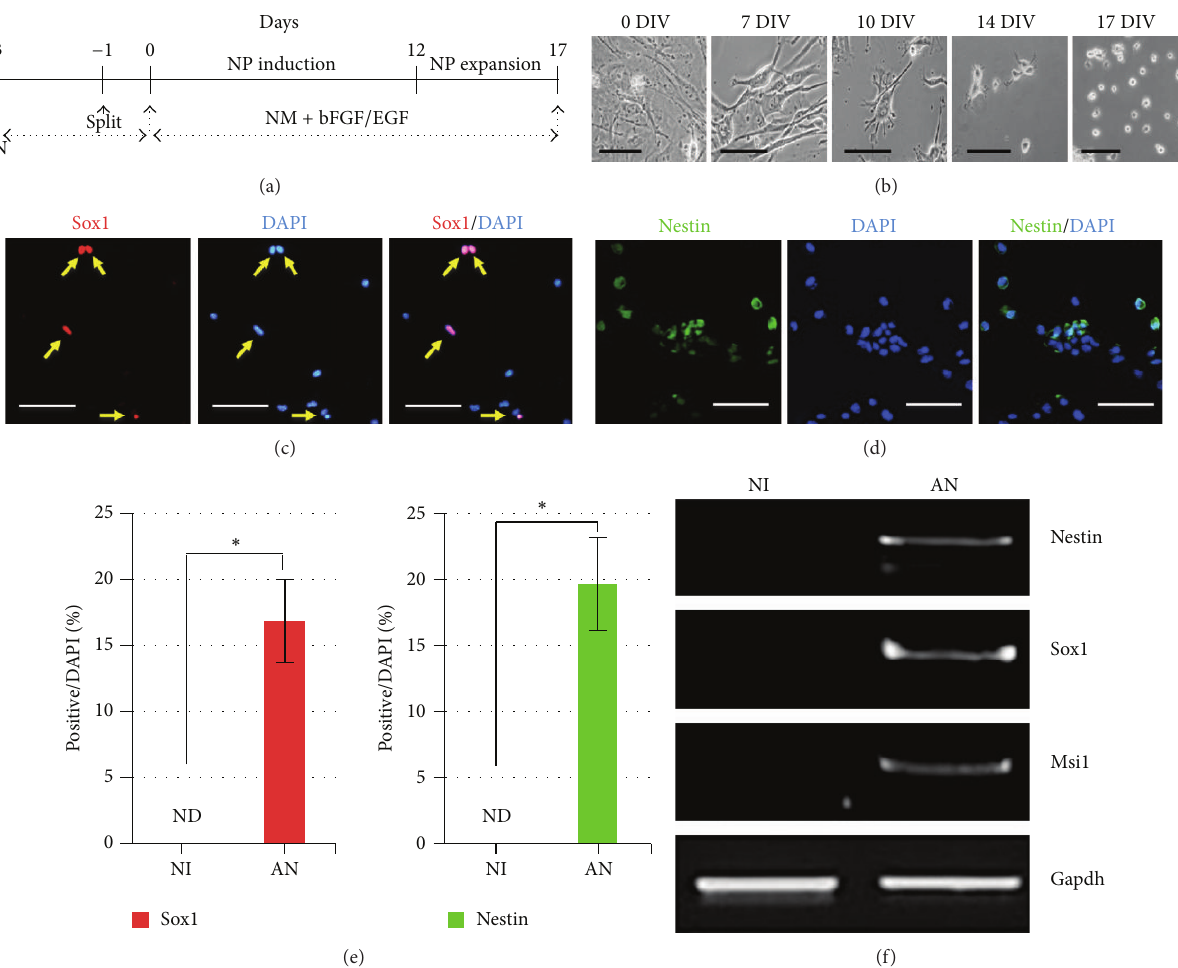
Figure 2: Direct conversion of MEF cells into neural precursor (NP) cells. (a) A schematic diagram for the generation of MEF-derived NP cells. (b) Representative phase-contrast images. Magnification × 200; scale bar is 100 𝜇 m. ((c), (d)) Representative immunofluorescence image of differentiated MEF cells stained with Nestin and Sox1 antibodies. Yellow arrows on the above micrograph indicate Sox1-stained cells. Magnification × 200; scale bar is 50 𝜇 m. (e) Reprogramming efficiency. Sox1-positive (red bar) and Nestin-positive (green bar) cells per DAPI-positive cells. Single asterisk is 𝑃 < 0.01 . (f) mRNA expression of neural precursor marker genes Nestin, Sox1, and Msi1 by